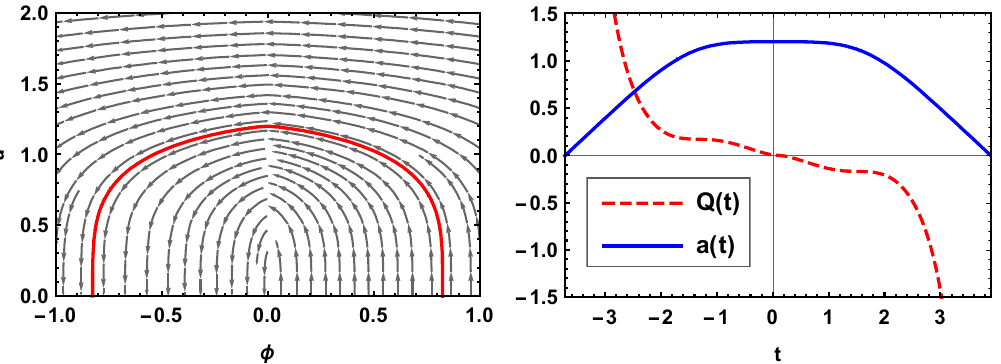
Figure 3. The phase portrait of system (36), for the dust case ( w = 0) is shown on the left-hand side, with V 0 = φ 0 = k = 1, and the red line represents the solution for which φ ( 0 ) = 0.0001 and a ( 0 ) = 1.2, as an example. On the right-hand side, we see the behavior of the scale factor (thick line) and the quantum potential (37) (dashed line), both being evaluated for the particular solution highlighted in the phase portrait.